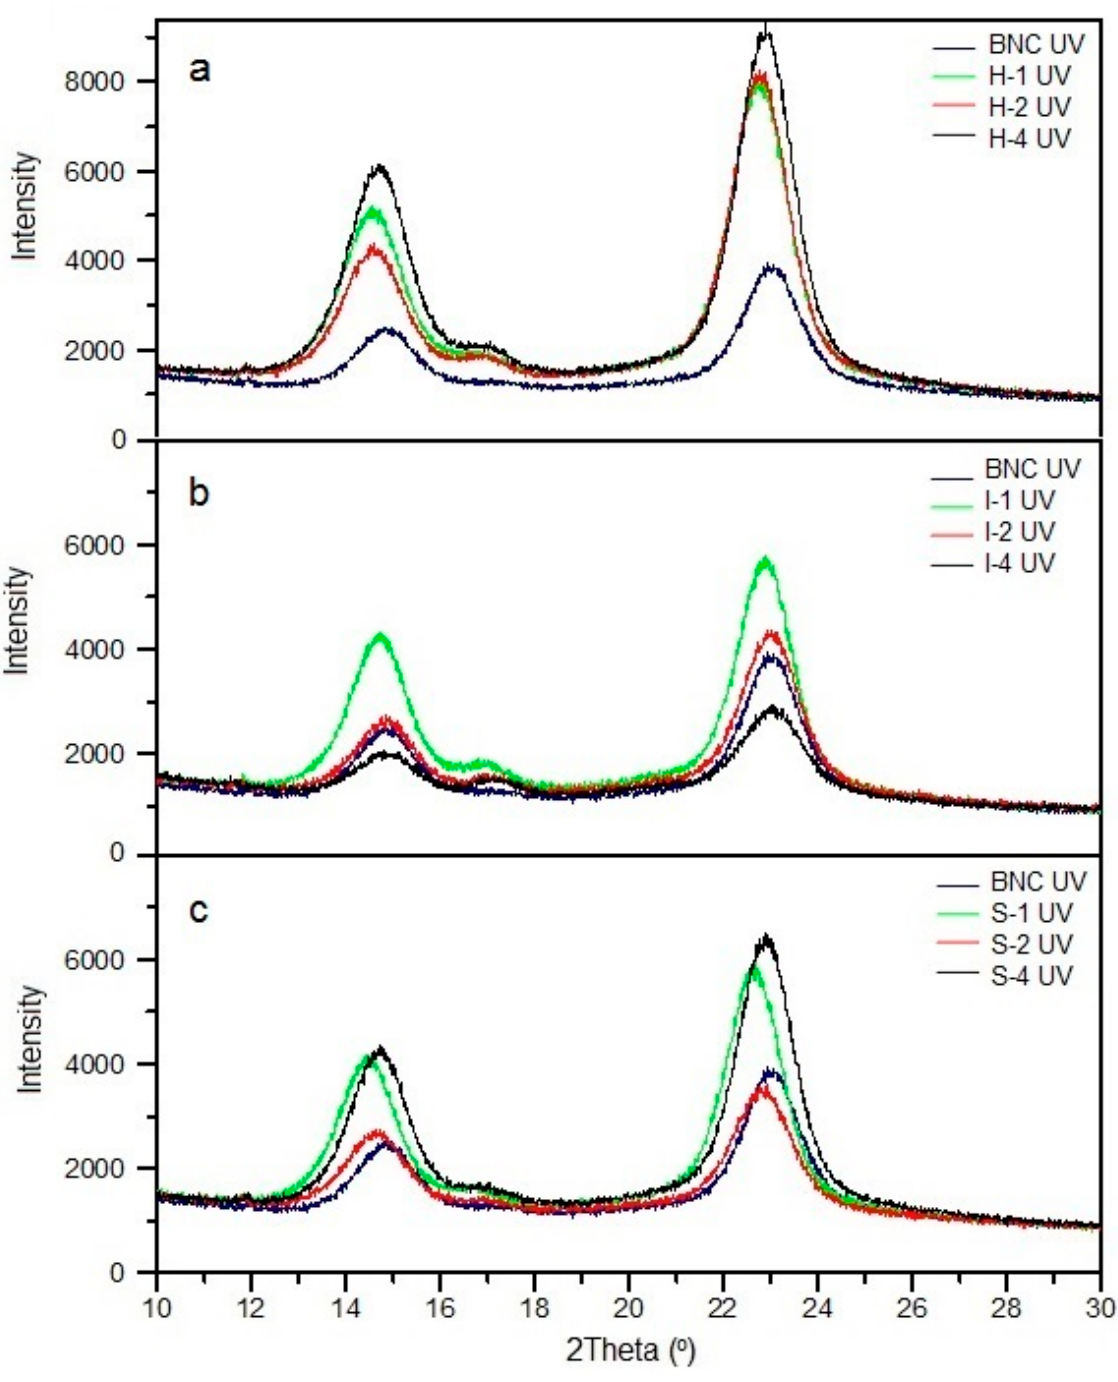
Figure 2. XRD patterns of UV-irradiated BNC/PVA blends obtained by in situ ( a ), ex situ/impregnation ( b ), and ex situ/sterilization ( c ) methods. The full width at half maximum (FWHM) values of two main signals on XRD patterns of BNC and BNC/PVA blends and the differences with these values for non-irradiated samples are listed in Table 1. These results show an increase in FWHM of both main reflections in the XRD caused by UV exposure for most of the analyzed samples (including virgin BNC). The exceptions are the samples I-2 and I-4, for which the FWHM decreases due to the sample